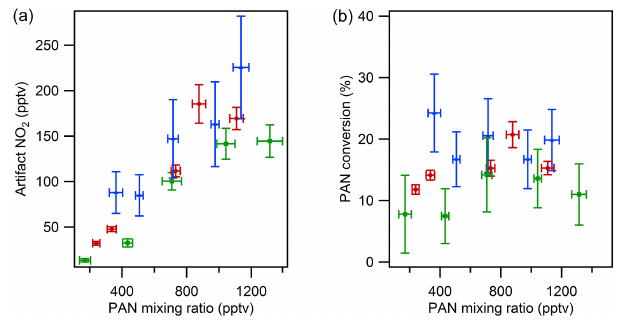
Figure 2. The measured NO 2 artifact signal (a) of the supplied PAN mixing ratio, and as a percentage (b) , for three BLC units operating in constant mode separated by NO 2 conversion efficiency. Green: 41%; red: 35%; blue: 22%.